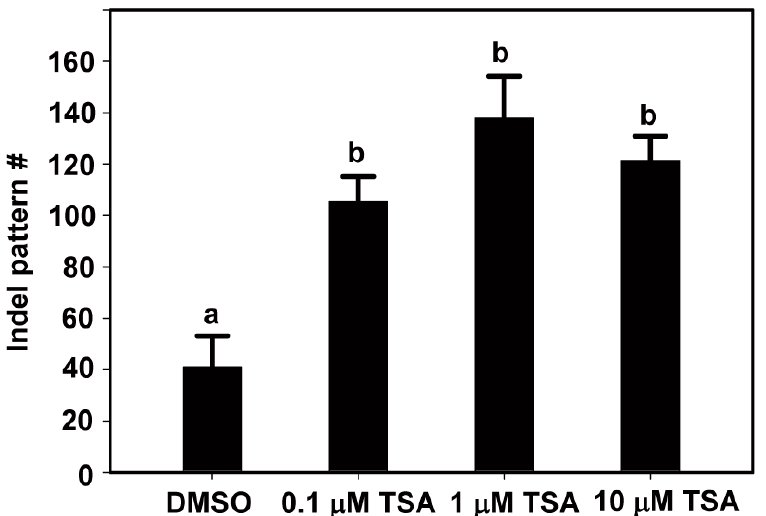
Figure 2. The number of indel patterns at the LsSOC1 target loci in protoplasts examined at 48 h after transfection of Cas9 protein and gRNAs as RNP complexes with DMSO or TSA treatment. The total number of various indel patterns according to TSA treatment was analyzed by targeted deep sequencing.